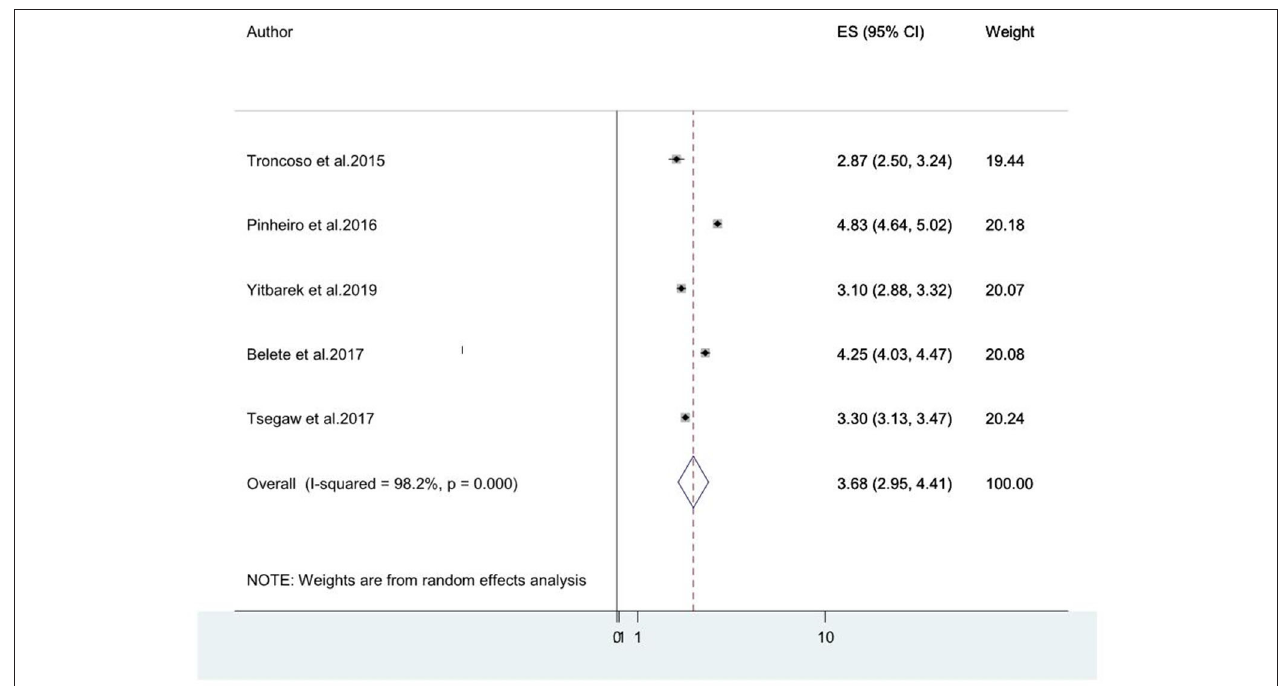
FIGURE 7 | A forest plot for the pooled odds ratio of associated between old age and HIV-associated neurocognitive disorder.